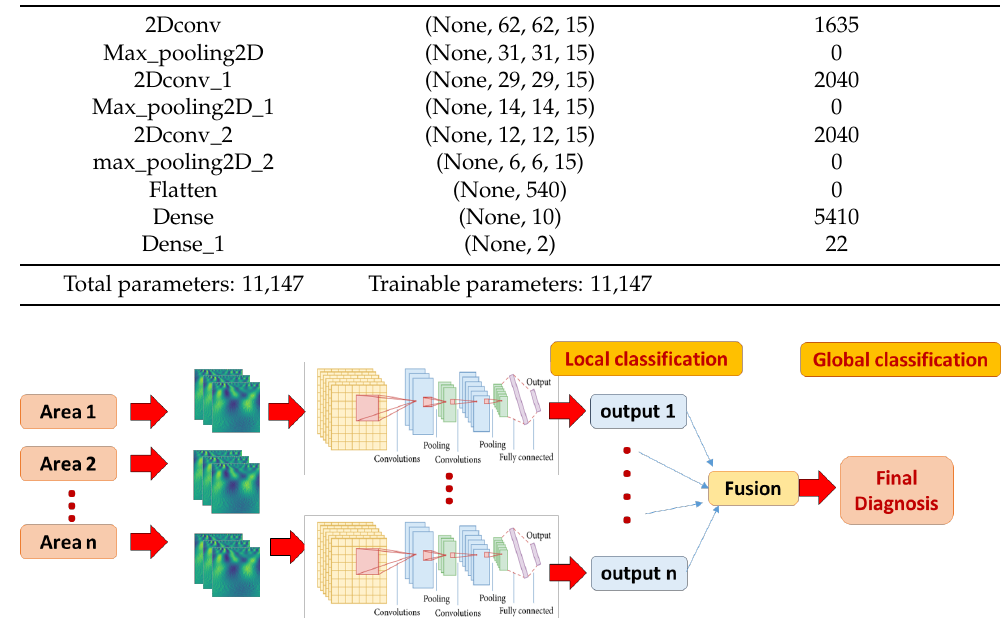
Figure 3. The local and global classification pipeline. A multi-channel 2D CNN local model is developed for each area, fed with corresponding CWT scalograms. The final global classification decision is fused using majority voting